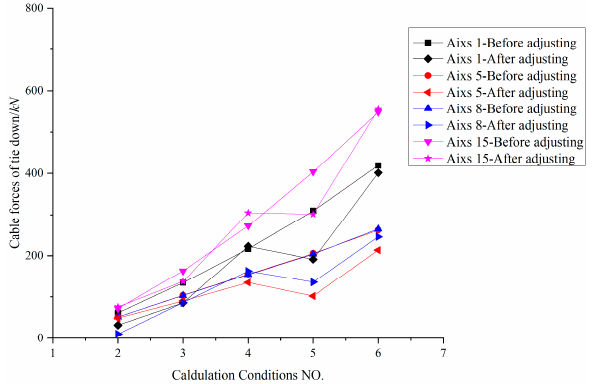
Figure 45. Four selected groups of tie-down forces before and after adjusting.